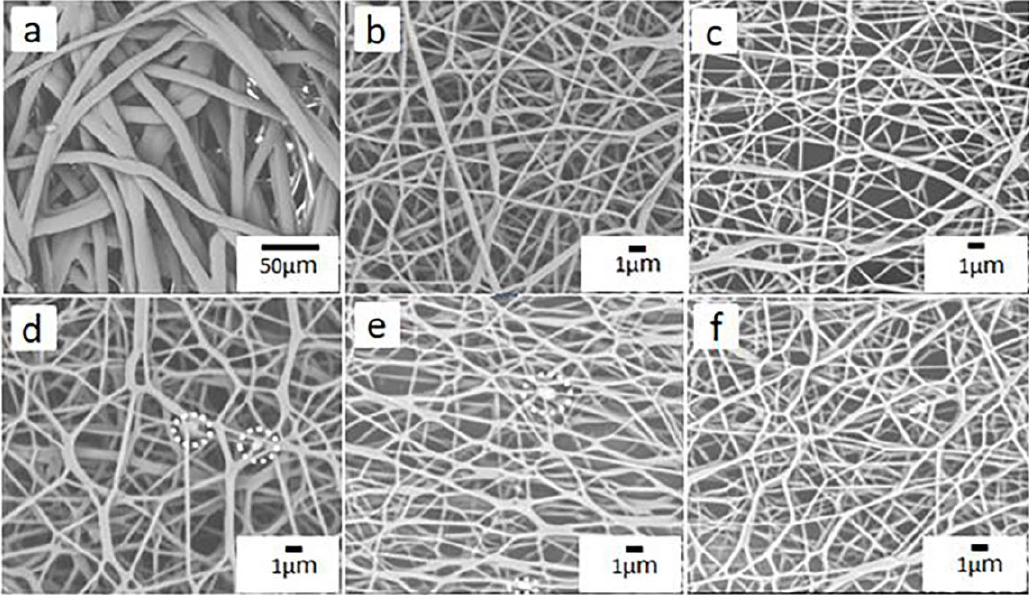
Figure 3. Scanning electron microscope (SEM) images of electrospinning: ( a ) PP melt-blown membranes, ( b ) PP/PVA, ( c ) PP/PVA/ZIF-8–1.25%, ( d ) PP/PVA/ZIF-8-2.5%, ( e ) PP/PVA/ZIF-8-3.75%, and ( f ) PP/PVA/ZIF-8-5%.